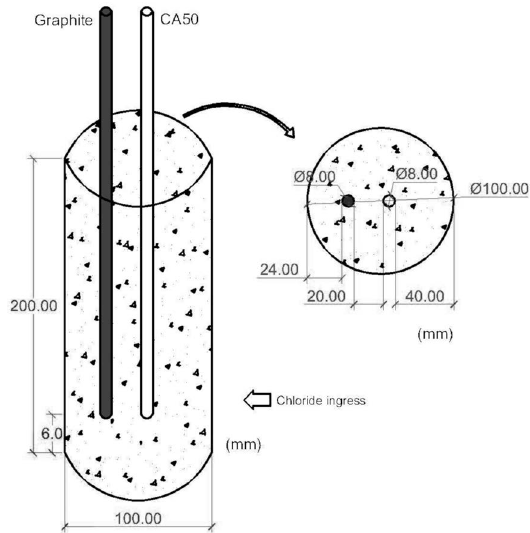
Figure 1. Samples used for the electrochemical impedance analysis.